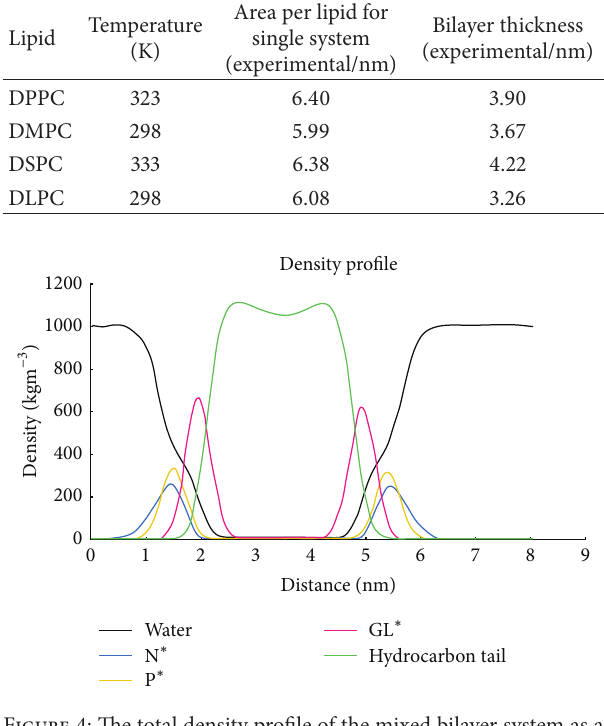
Figure 4: The total density profile of the mixed bilayer system as a function of distance at 298 K.